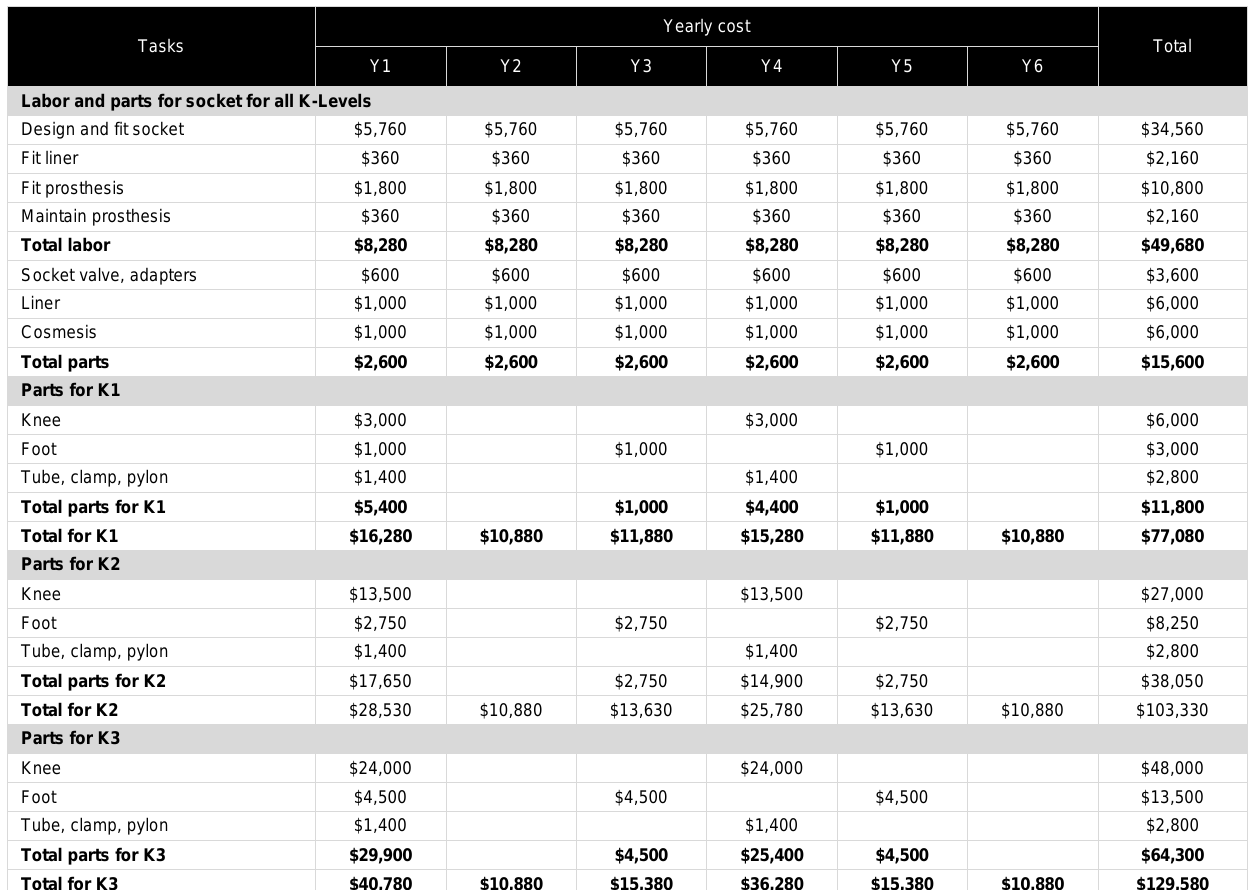
Table 3: Schedule of typical allowable expenses over six-year time horizon with yearly breakdown of labor and parts costs allocated for provision of transfemoral socket-suspended prostheses attached to residuum with distal weight bearing Keep Walking Implant for each K-